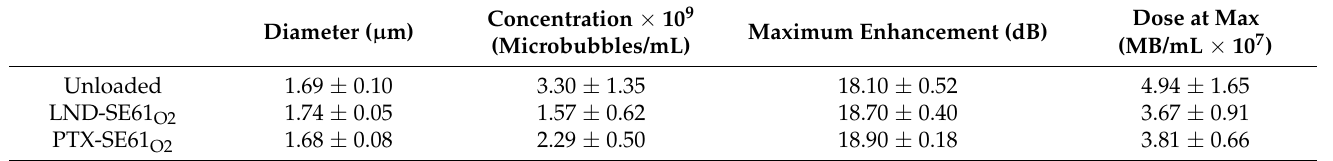
Table 1. Effect of single-drug incorporation on microbubble size, concentration, and acoustic